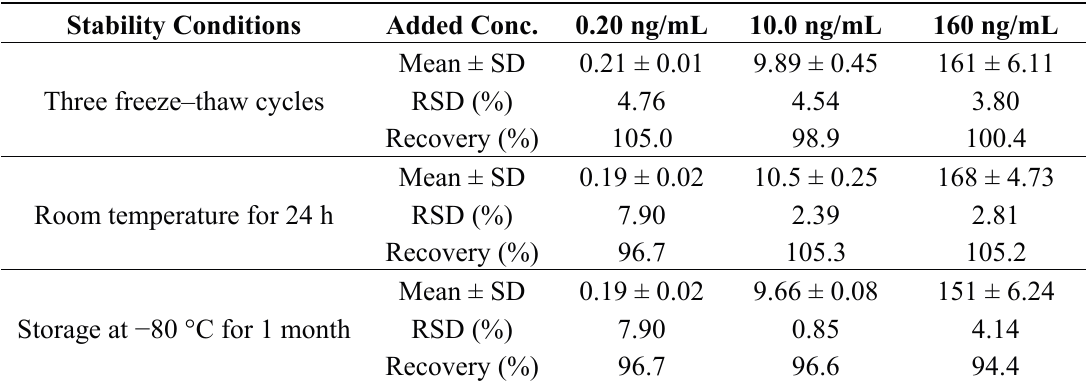
Table 3. Stability of PD in rat plasma ( n = 5).